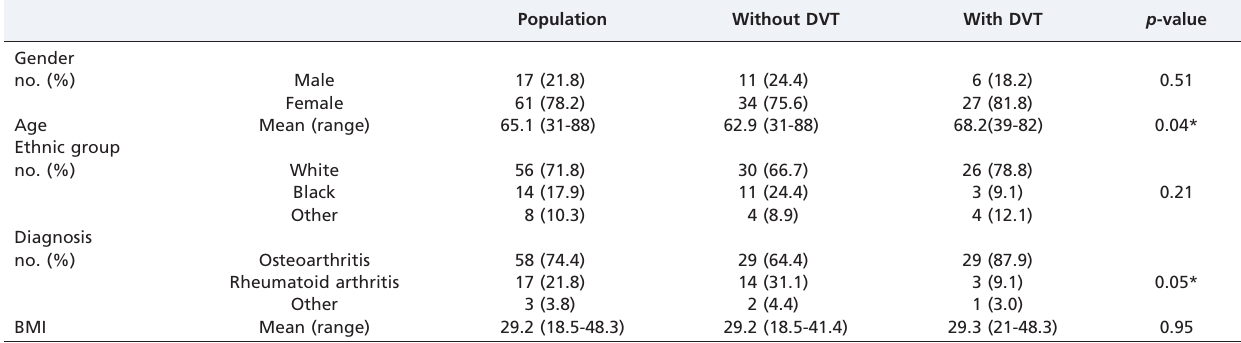
Table 1 - Patient baseline characteristics.